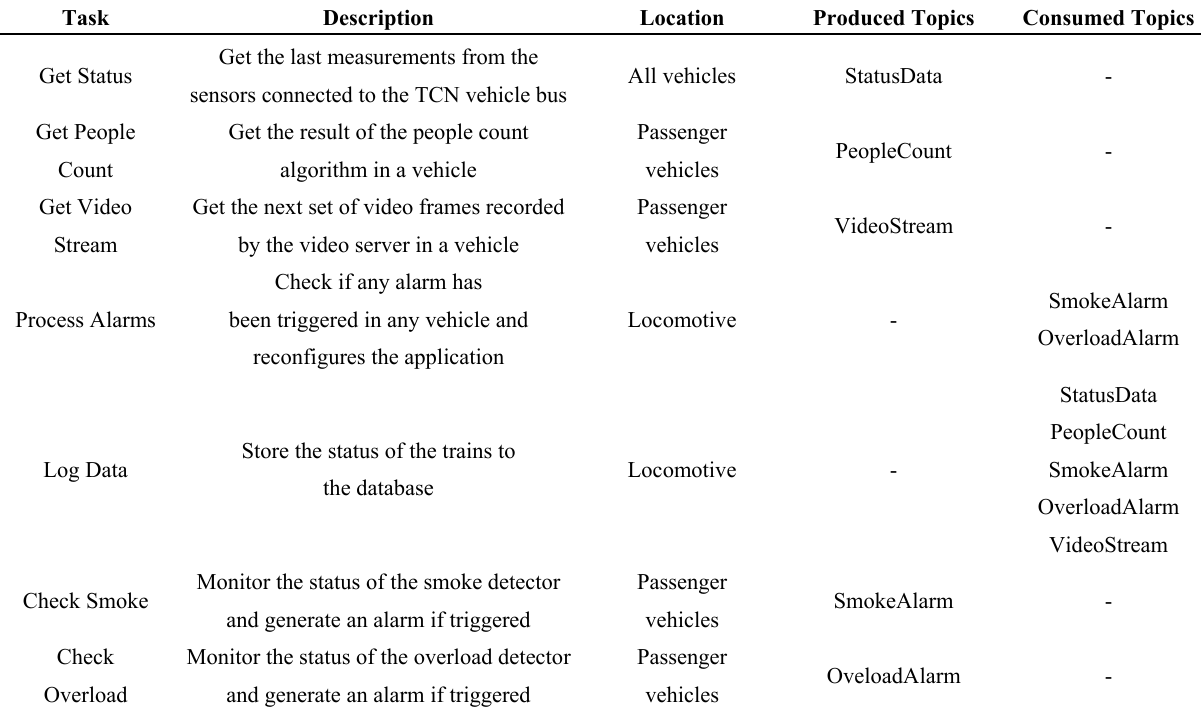
Table 2. Description of the tasks of the TCN